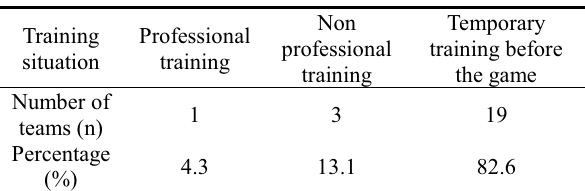
Table 5 Training table of dragon boat team in all parts